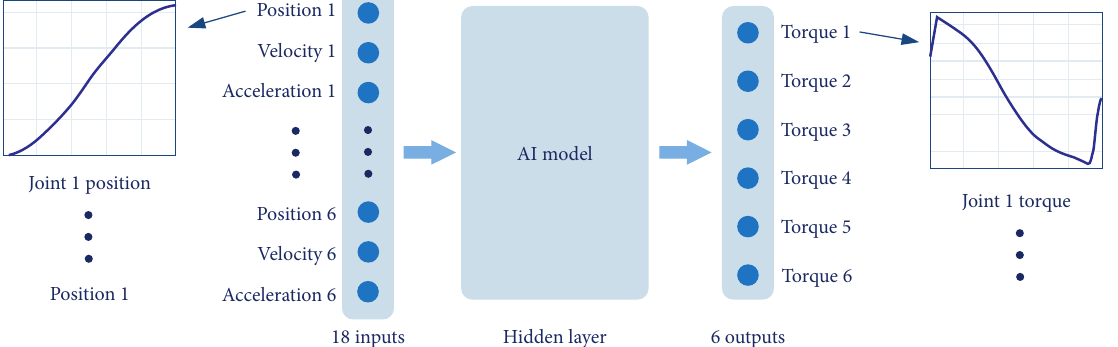
Figure 2: Inverse dynamics learning architecture of manipulator with 21 input data sets.